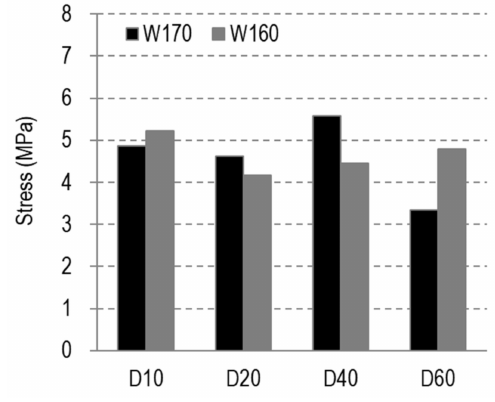
Figure 11. Drying shrinkage stress at